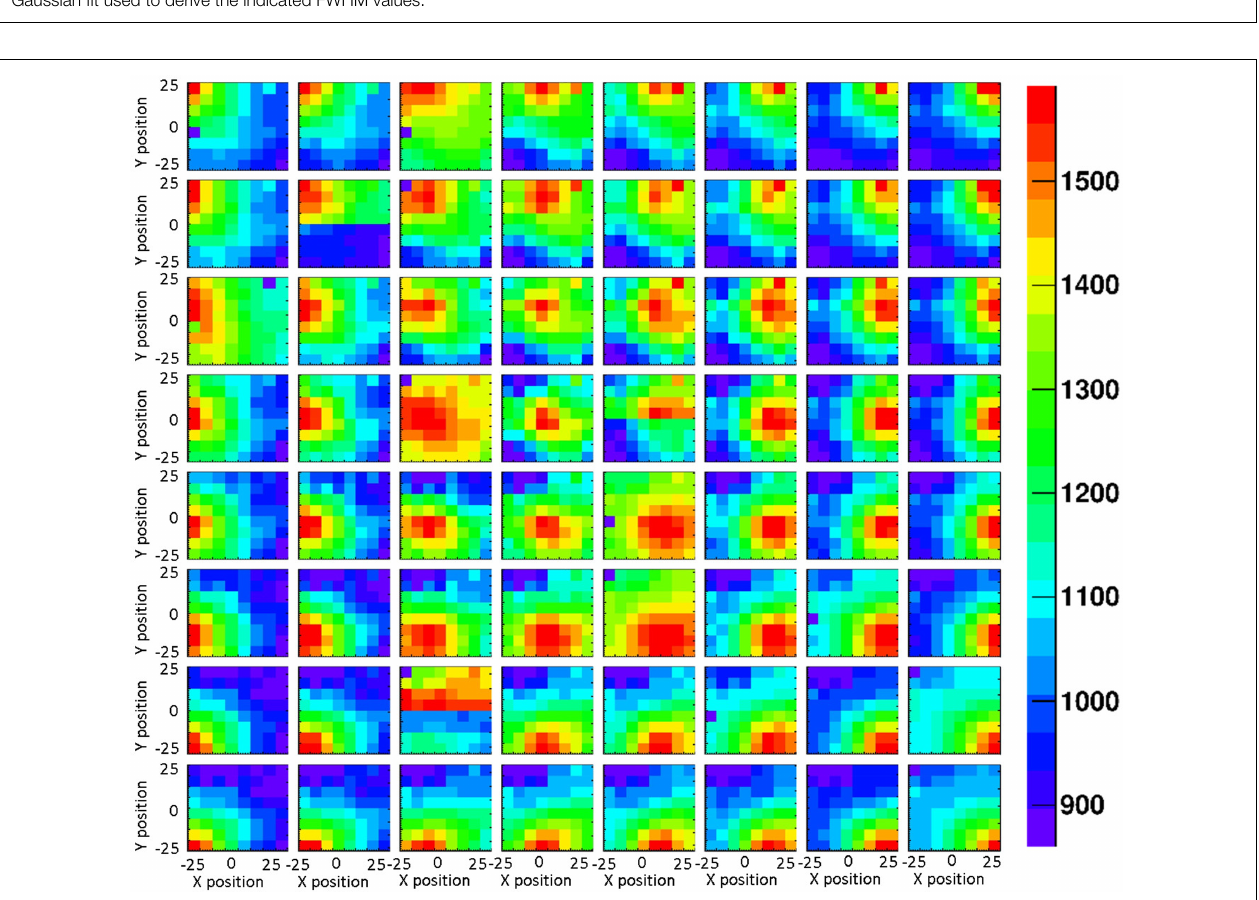
FIGURE 6 | 2D light amplitude distribution obtained from an 8 (cid:2) 8 grid scan of the absorptively wrapped LaBr 3 :Ce detector, using a 1mm collimated 137 Cs source with a step size of 6mm in x and y direction . Each subpicture represents light amplitude distribution of an irradiation position. The corresponding correlation of the resulting light amplitude distributions (after the analysis steps described in Sect. 2) with the shift of the irradiation position is clearly